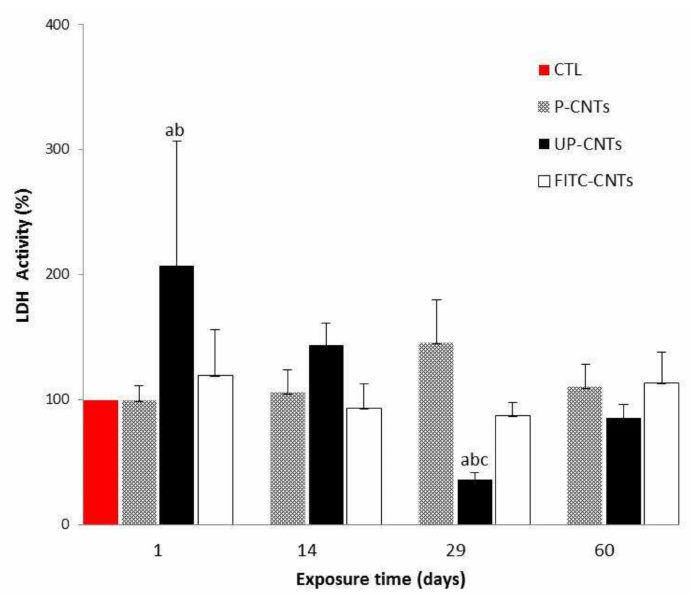
Figure 7. E ff ect of exposure with di ff erent CNTs on the relative activity of LDH. Relative activities of serum LDH in mice exposed to di ff erent CNTs at 1, 14, 29, and 60 days post exposure. Each bar represents the mean ± SE of each group ( n = 4). a: di ff erence with respect to the control without stimulus ( p < 0.05). b: di ff erence between treatments ( p < 0.05), and c: di ff erence between times post exposure ( p < 0.05).